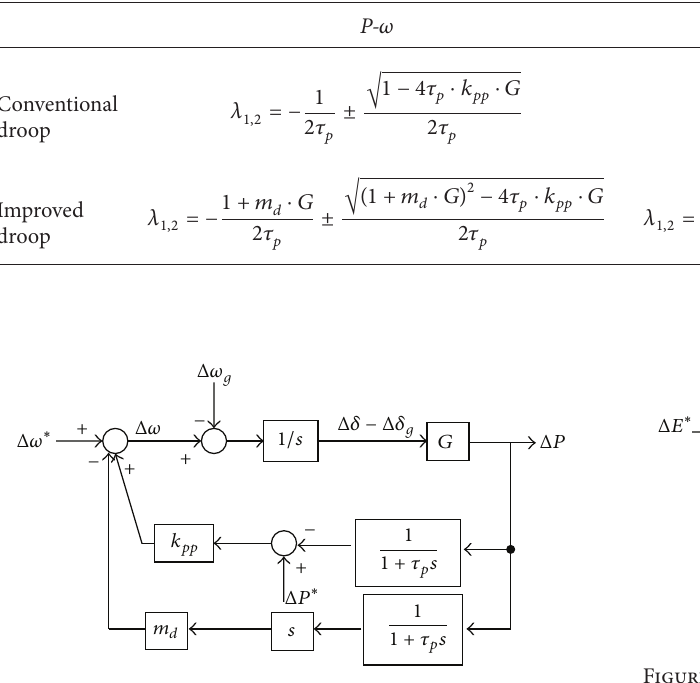
Figure 5: Small signal model of the improved 𝑃 - 𝜔 droop control.